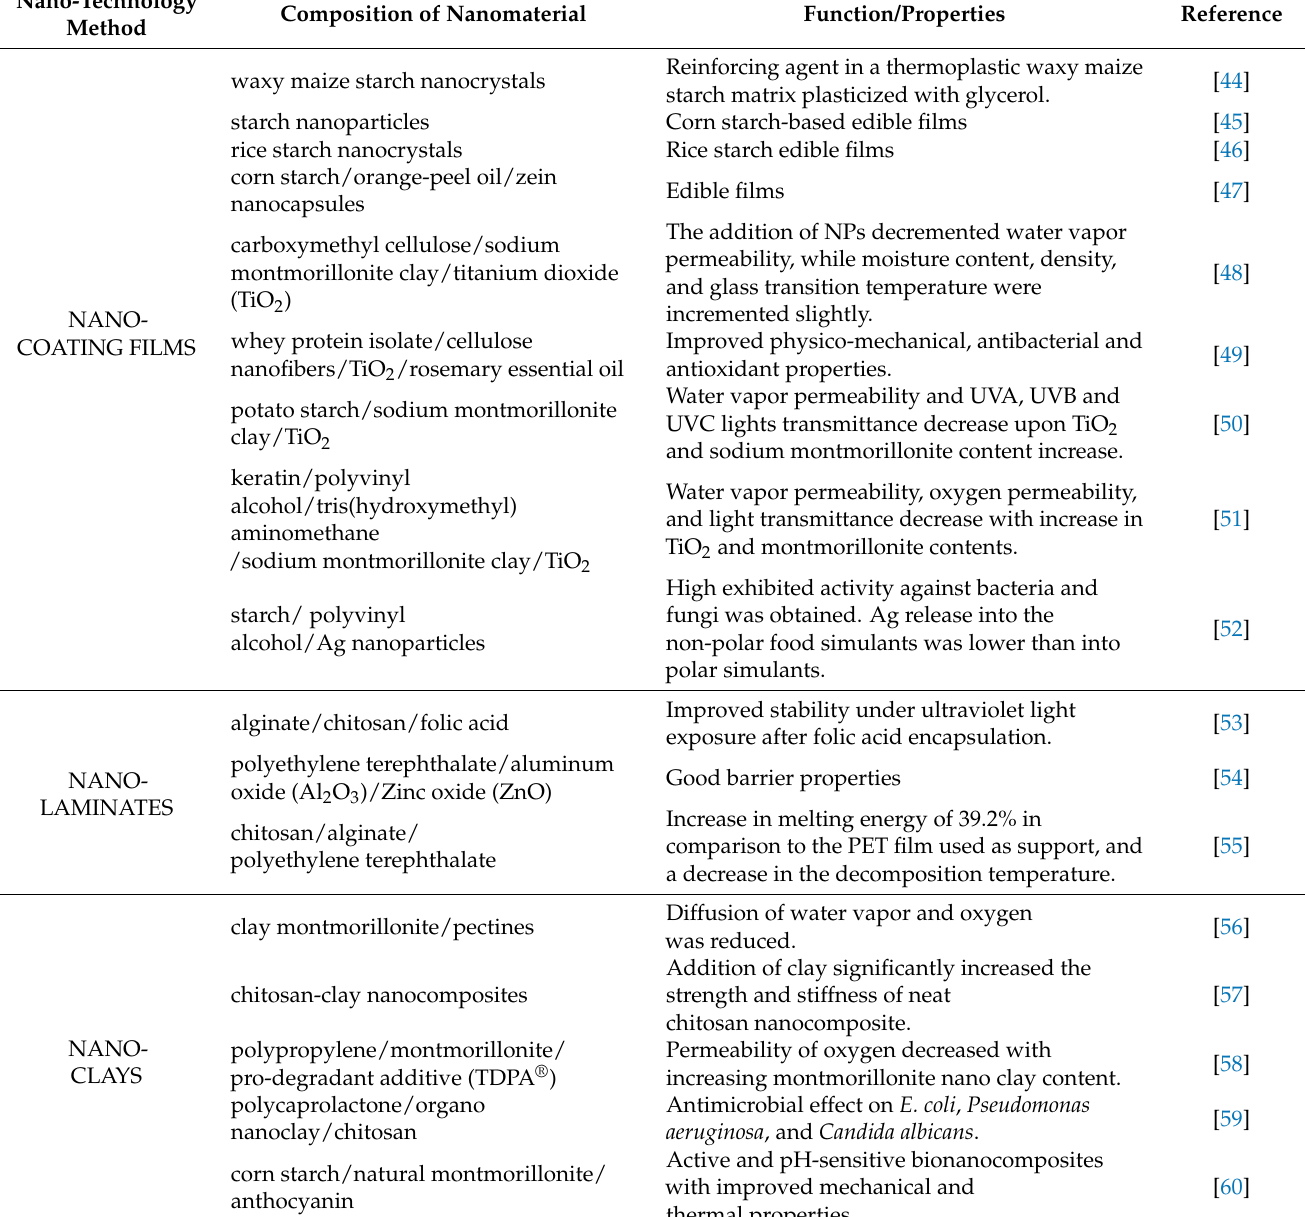
Table 2. Different nanotechnology methods for the preparation of nanomaterials suitable for improved food